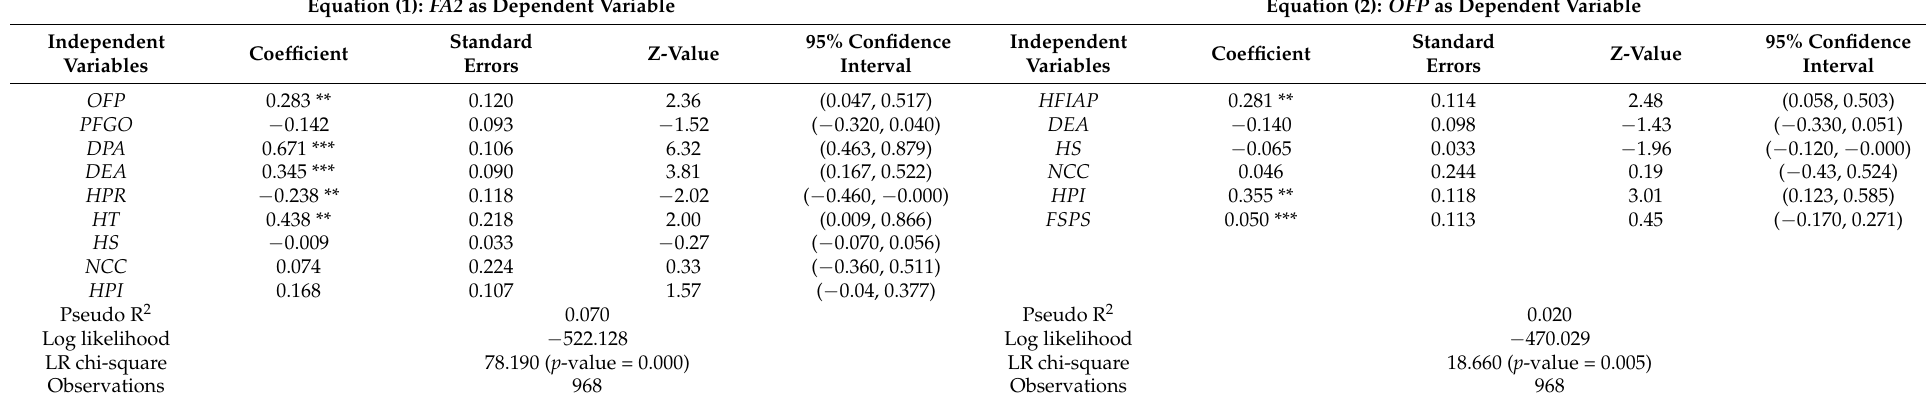
Table 7. Results of robustness tests of model II.